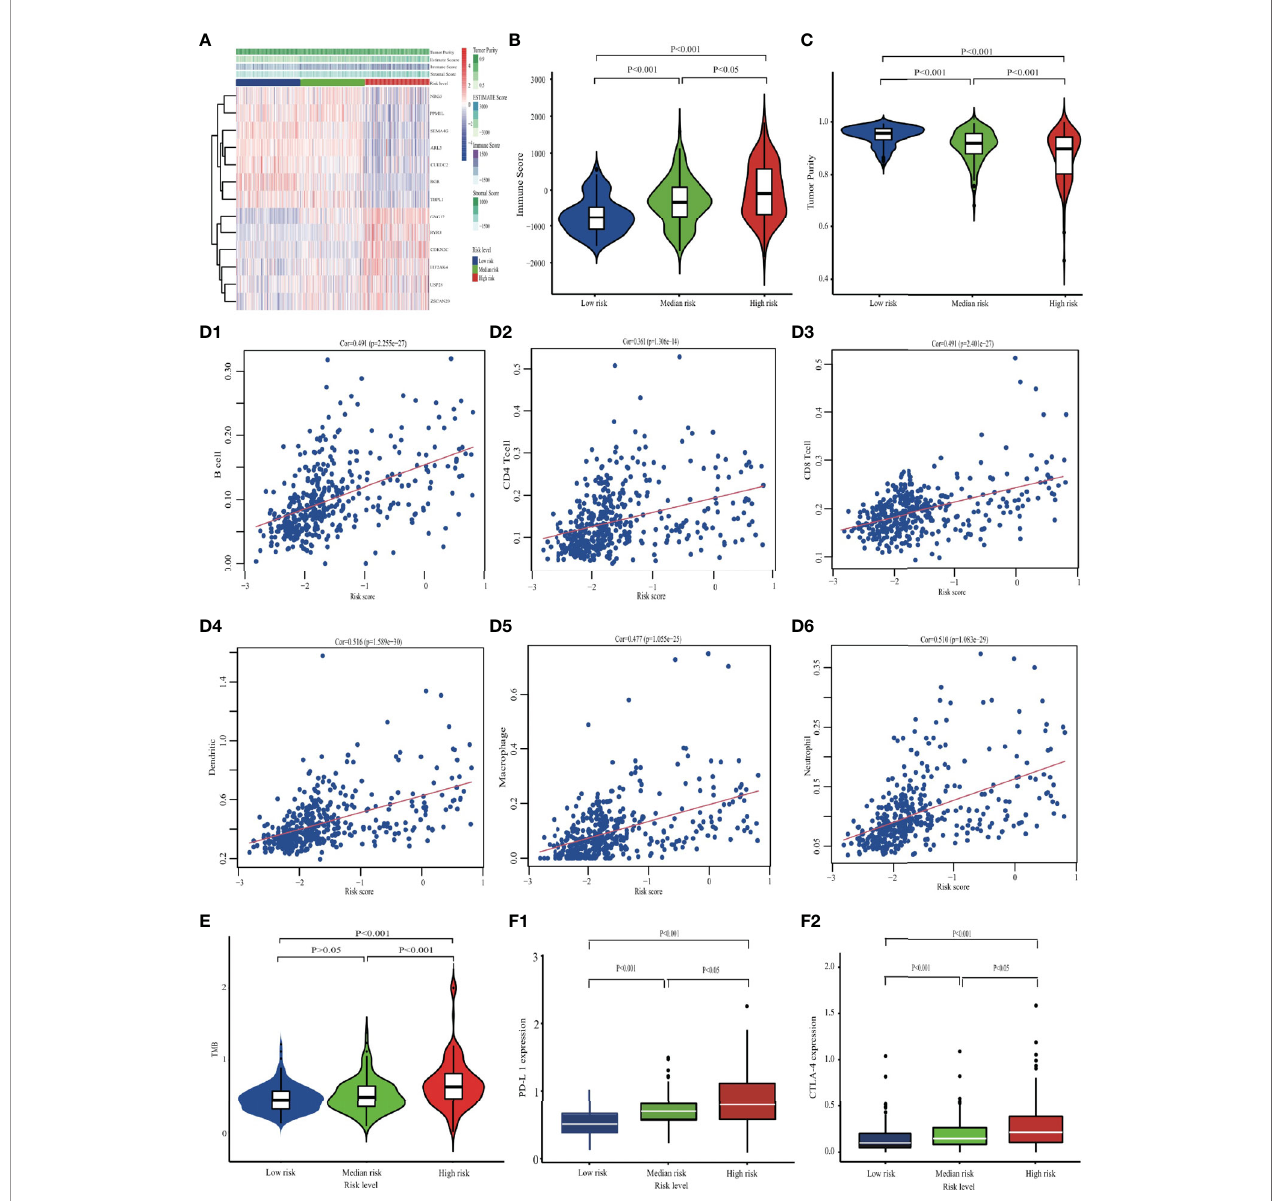
FIGURE 7 | Comparing the immune characteristics among different risk groups in the TCGA cohort. (A) The overall immune microenvironment landscape. (B) The comparison of Immune score, and (C) tumor purity. (D) The correlation between six immune cells and EDGs signature. (E) Differences in TMB among low-, mid- and high-risk groups. (F) The differences in checkpoint expression.